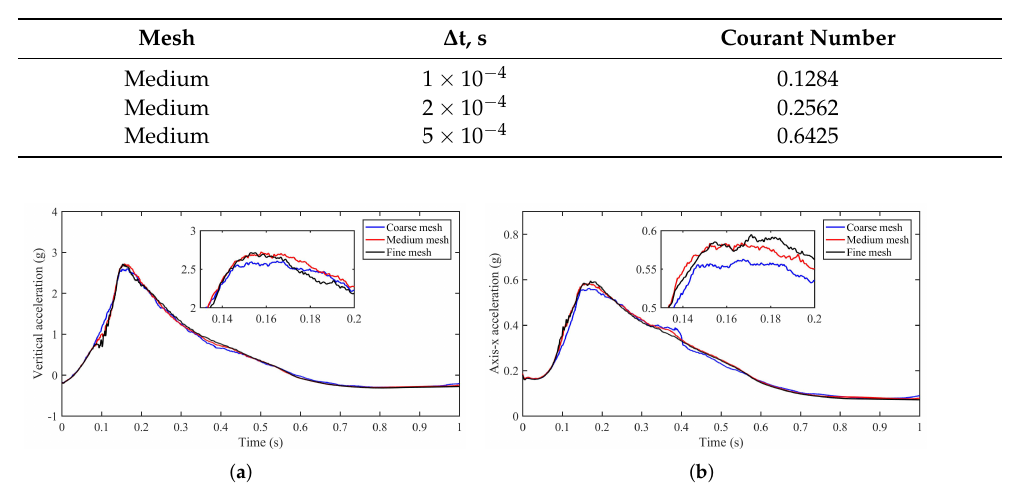
Table 2. Time step size convergence study.